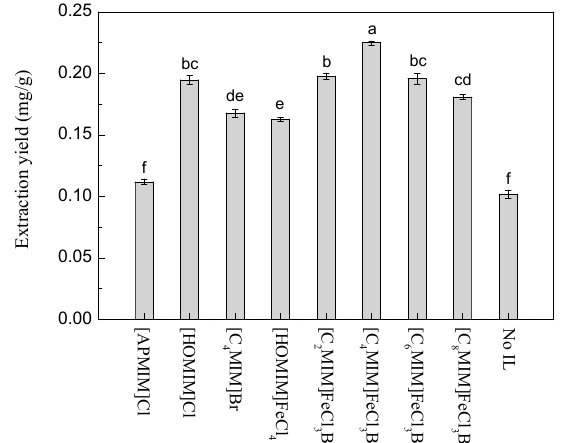
Figure 1. Effect of different ionic liquids (ILs) used as adjuvants to the extraction yields of paclitaxel (Extraction conditions: 0.5 g T. x media leaves powder, 60 vol % methanol, 1.0 wt % IL added, 1:10 solid–liquid ratio, 40 °C extraction temperature, and 30 min ultrasonic irradiation time) . Different letters in the same series indicate significant difference at p < 0.05 level .